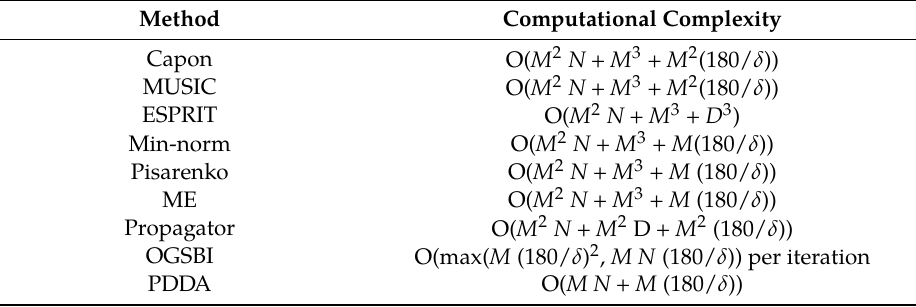
Table 4. Showing the overall computational complexity comparison between PDDA and popular AOA methods.